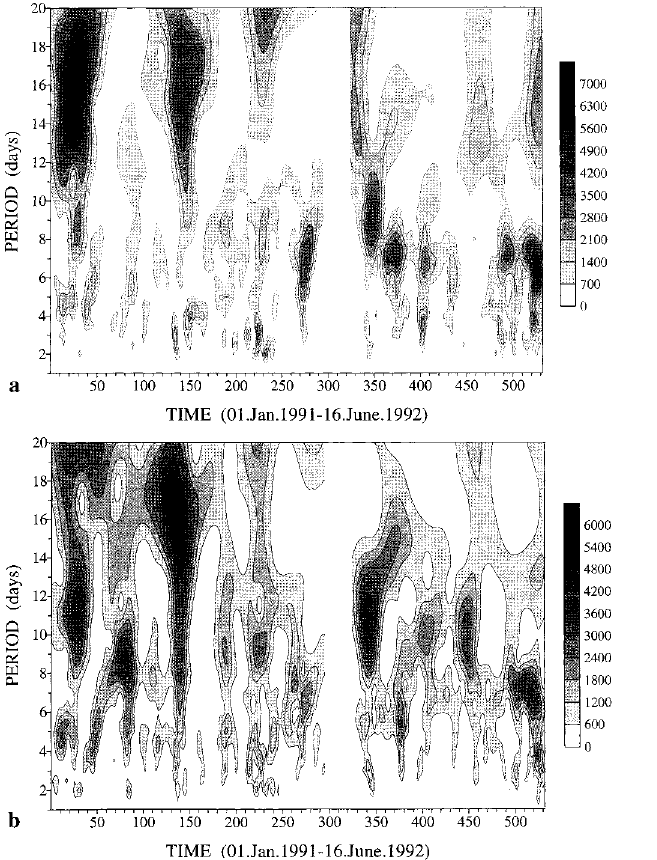
Fig. 14a, b. The cross-wavelet spectra obtained between: a the mean meridional wind and the amplitudes of the semidiurnal meridional tide, and b the mean meridional wind and the amplitudes of the diurnal meridional